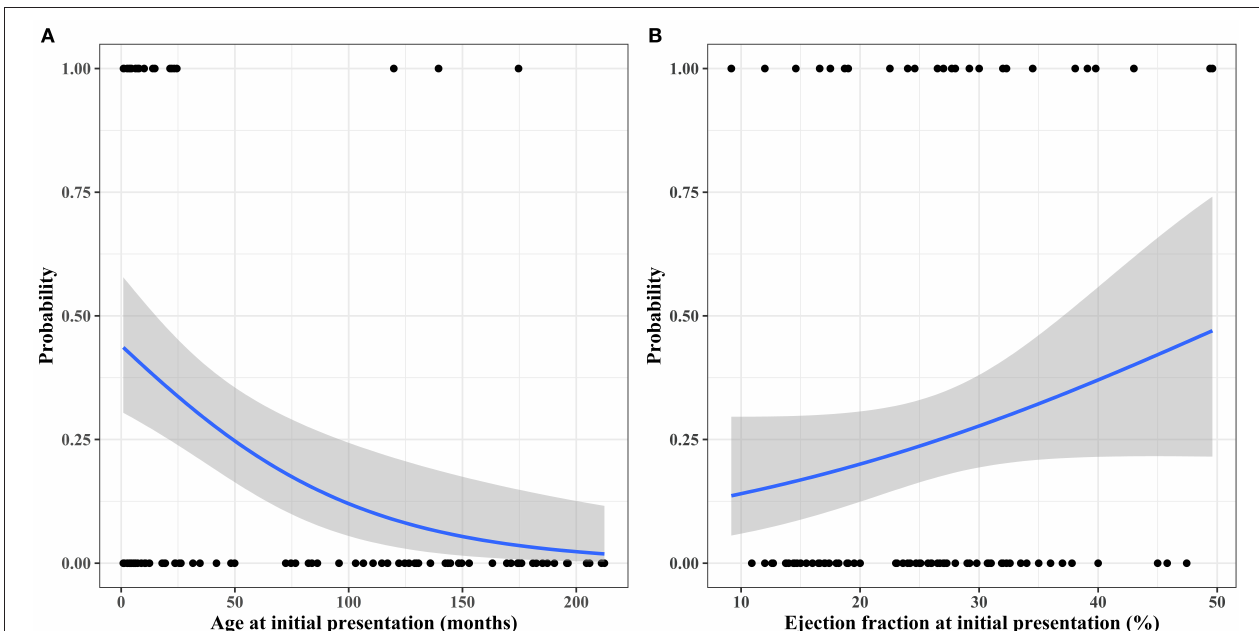
FIGURE 5 | Probability curves for functional recovery within 2 years after initial presentation according to (A) age at initial presentation and (B) initial left ventricular ejection fraction.